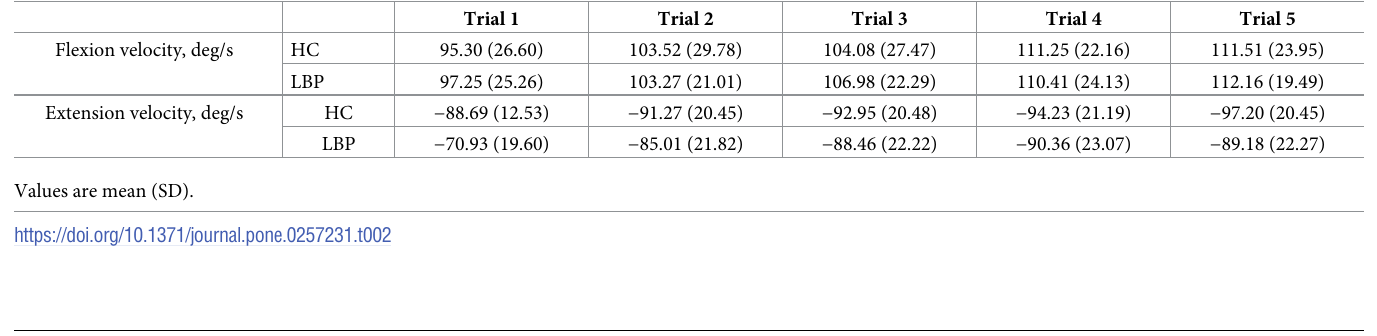
Values are median (interquartile range) or n (%). �